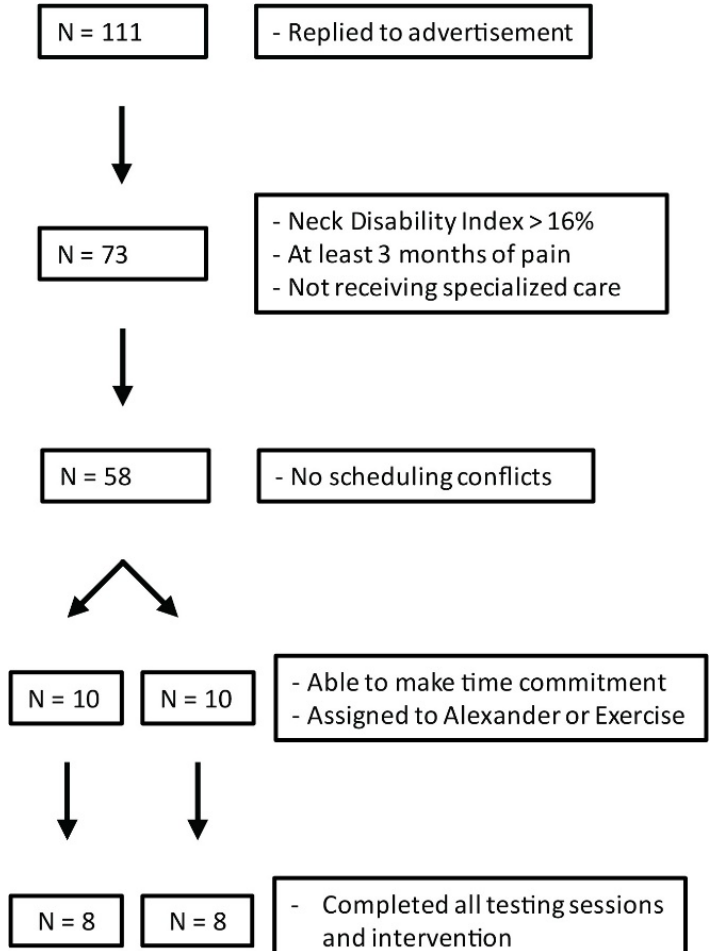
Figure 2. Flow chart of participant recruitment and attrition. Of the subjects who dropped out after being assigned to a group, three subjects in the exercise group dropped out because of pain after the first session, and the other three subjects did not participate in any intervention